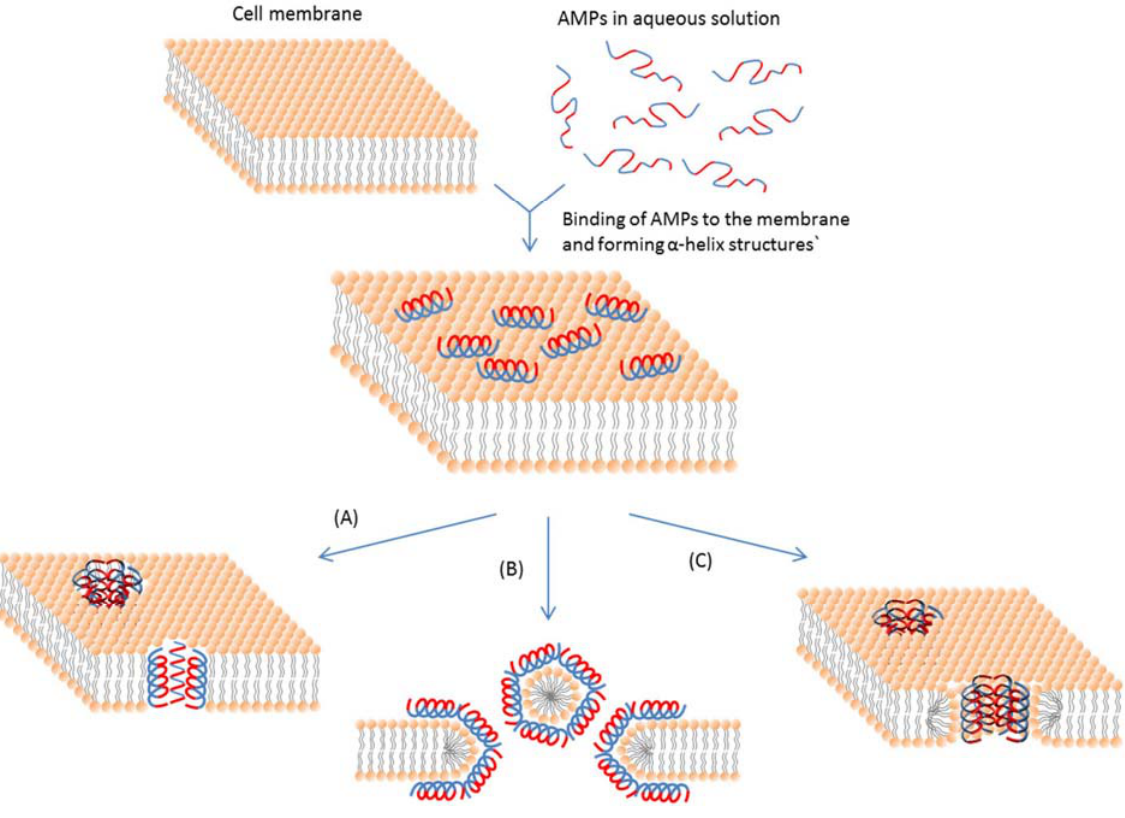
Figure 2. Schematic representation of some action mechanisms of membrane-active AMPs. ( A ) Barrel-Stave model. AMP molecules insert themselves into the membrane perpendicularly. ( B ) Carpet model. Small areas of the membrane are coated with AMP molecules with hydrophobic sides facing inward leaving pores behind in the membrane. ( C ) Toroidal pore model. This model resembles the Barrel-stave model, but AMPs are always in contact with phospholipid head groups of the membrane. The blue color represents the hydrophobic portions of AMPs, while the red color represents the hydrophilic parts of the